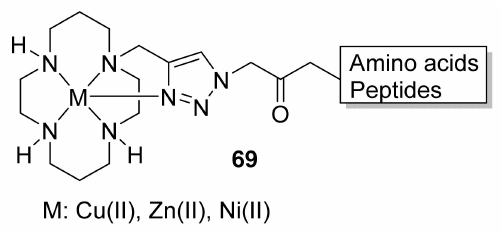
Figure 25. Cyclam metal complex